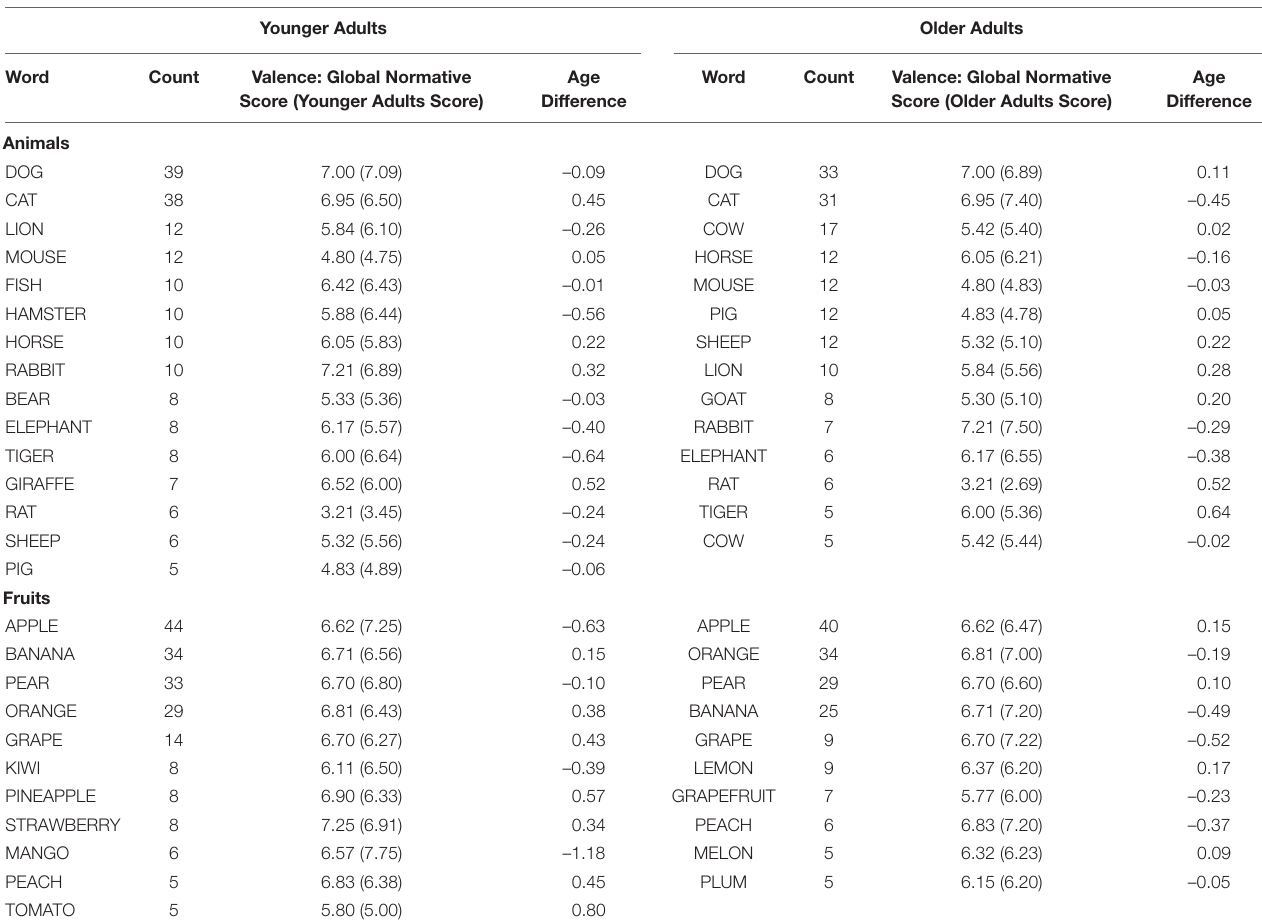
TABLE 3 | Words generated by each group in position